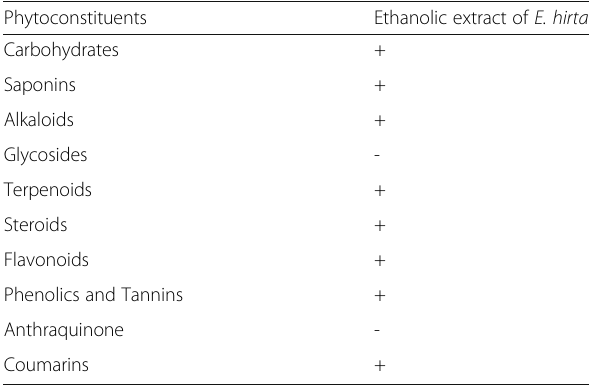
Table 2 Preliminary phytochemical analysis of E. hirta leaves extract Phytoconstituents